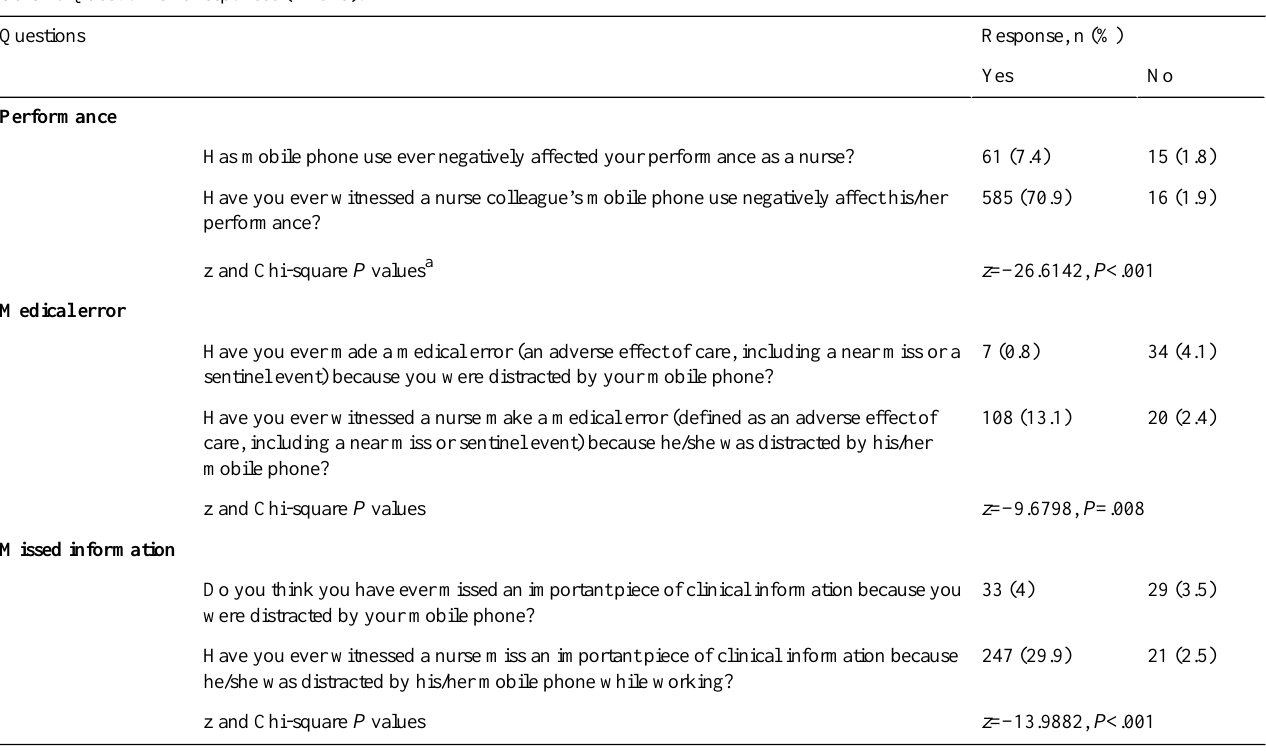
Table 1. Questionnaire responses